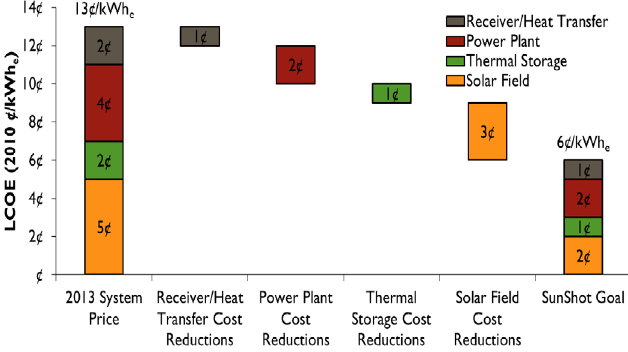
Fig. 7. Expected LCOE reduction in SunShot Concentrating Solar Power